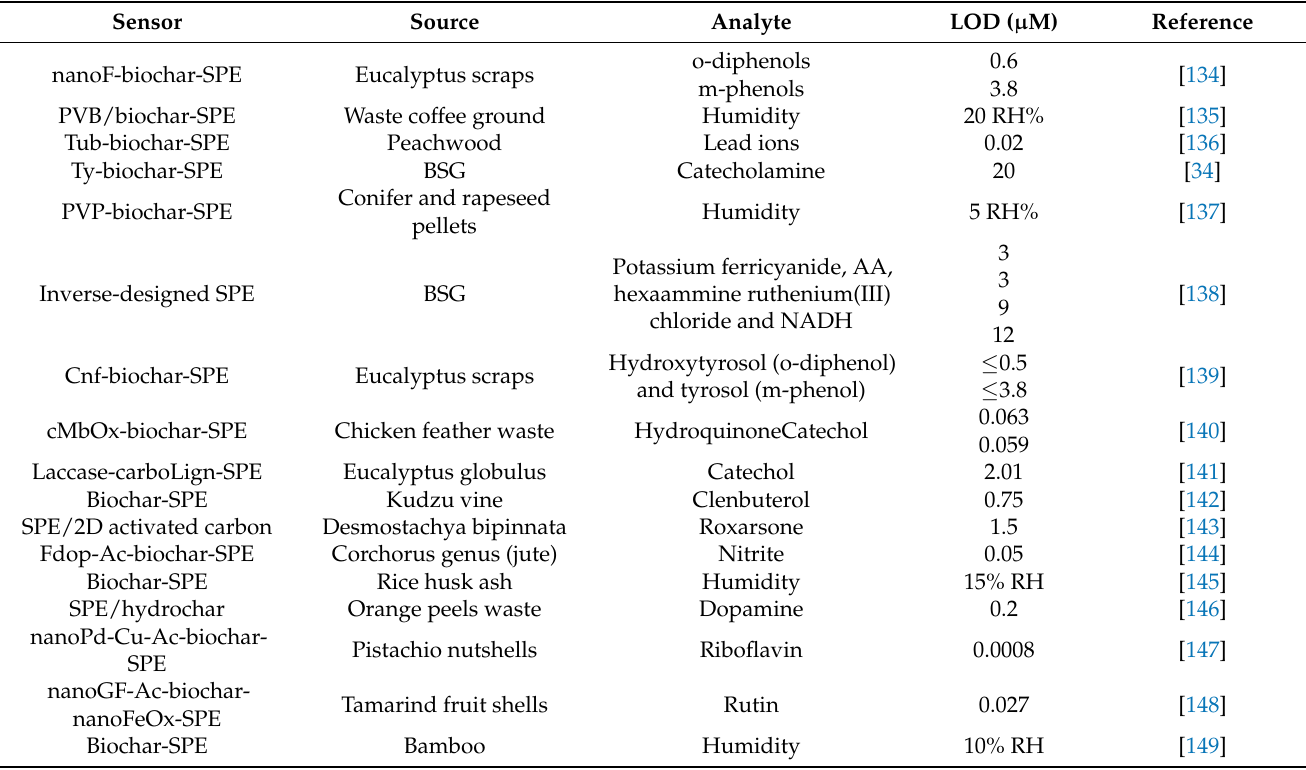
Table 6. Main source, preparation, application, limit of detection (LOD) and sensors based on